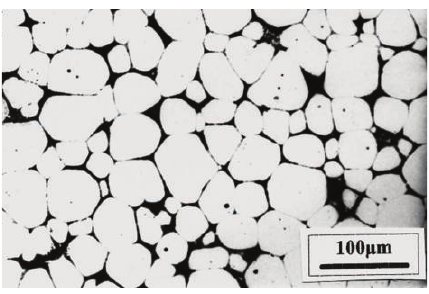
Figure 10: Microstructure of M2 tool steel obtained by spray forming